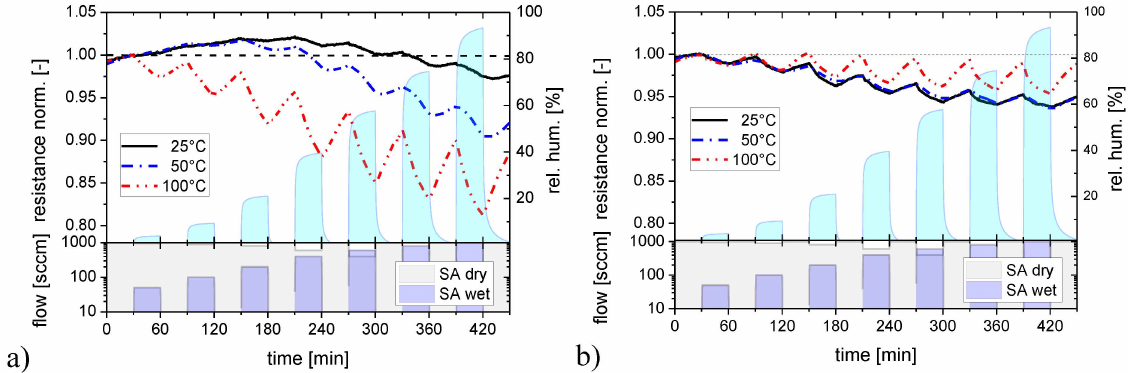
Figure 3. Response of SnO layers with a flat ( a ) and a nano-granular ( b ) surface 2 morphology towards water vapor at different sensor operation